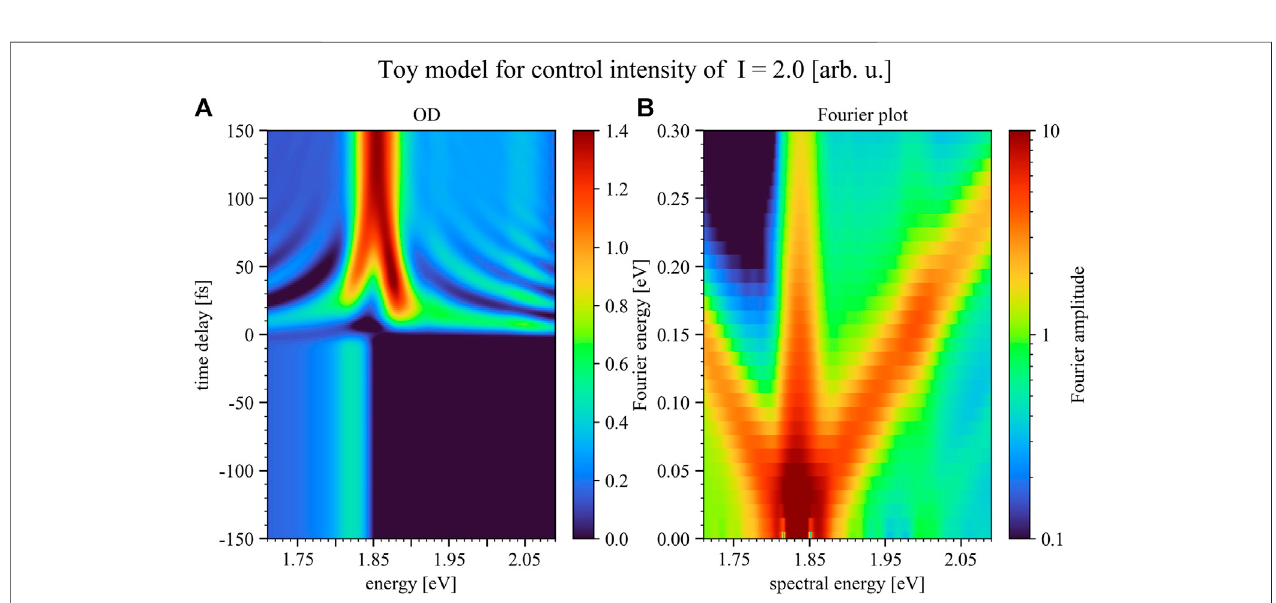
FIGURE9| Simulated time delaytrace (A) and Fourierplot (B) for positivetime delays only,but forthe caseofdoublethe control-pulse intensity of Figure 7 .Panel 9A depicts the modeled optical density over a time-delay range of 300 fs, where the color bar marks the magnitude of the OD. The Fourier plot (Panel 9B) reveals diagonals with slope ± 1 in a more pronounced fashion compared to the experimental data. The Rabi-/Autler-Townes splitting for small time delays near resonance can be observed to set in and grow with increasing control pulse intensity. Negative time delays refer to control-pulse fi rst, positive to excitation-pulse fi rst.